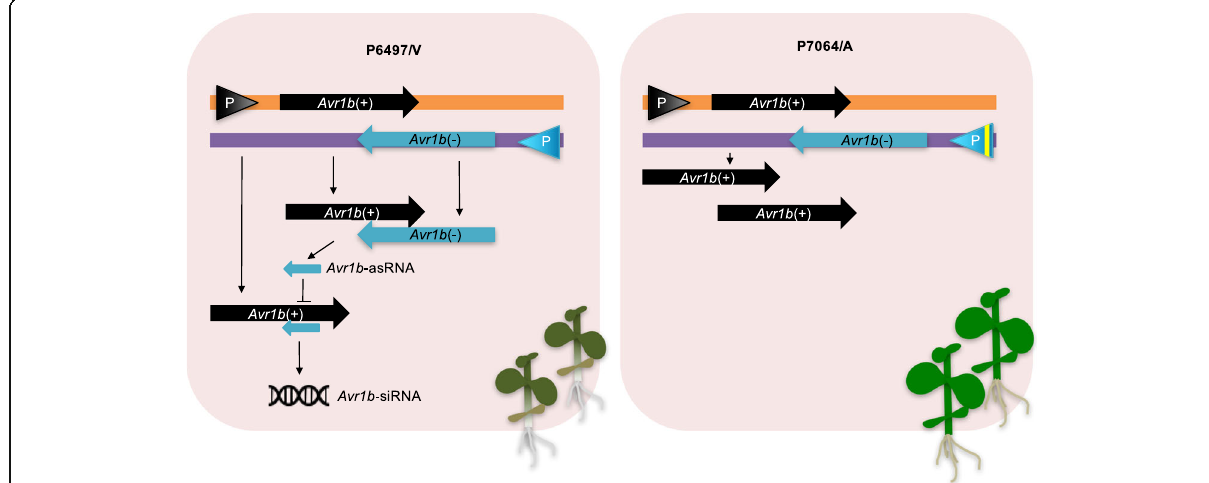
Fig. 7 A proposed molecular model for the regulation of Avr1b expression in the avirulent and virulent P. sojae strains. Both P. sojae strains P6497 and P7064 encodes Avr1b (+)and Avr1b ( − ) genes. In the virulent strain P6497 (the left panel), Avr1b (+) P6497 and Avr1b ( − ) P6497 are transcribed in a bidirectional manner and formed NATs during infection; the NATs are recognized by the putative endogenous cleavage machinery to produce Avr1b -asRNA P6497 . The produced sRNA targets on the newly transcribed Avr1b (+) P6497 and generates abundant Avr1b -siRNA P6497 that function as the RNA silencing signals, leading to abolished Avr1b (+) P6497 function and escaped Rps1b recognition. In the avirulent strain P7064 (the right silencing, allowing Avr1b (+) P7064 be recognized by